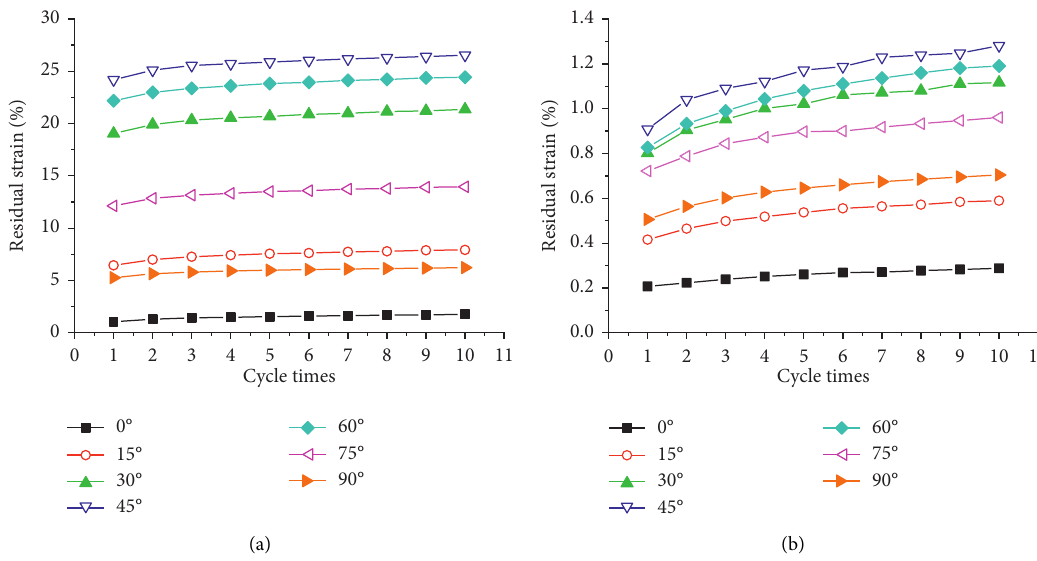
Figure 18: Relation between residual strain and cyclic times. (a) PVC membrane material. (b) PV-PVC composite.